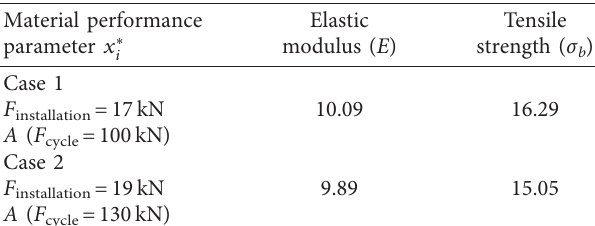
Figure 15: Variations in the fastening clip fatigue life with the tensile strength of the material. Table 8: Sensitivity factors S ( x ∗ i ) of the material static mechanical properties x ∗ i